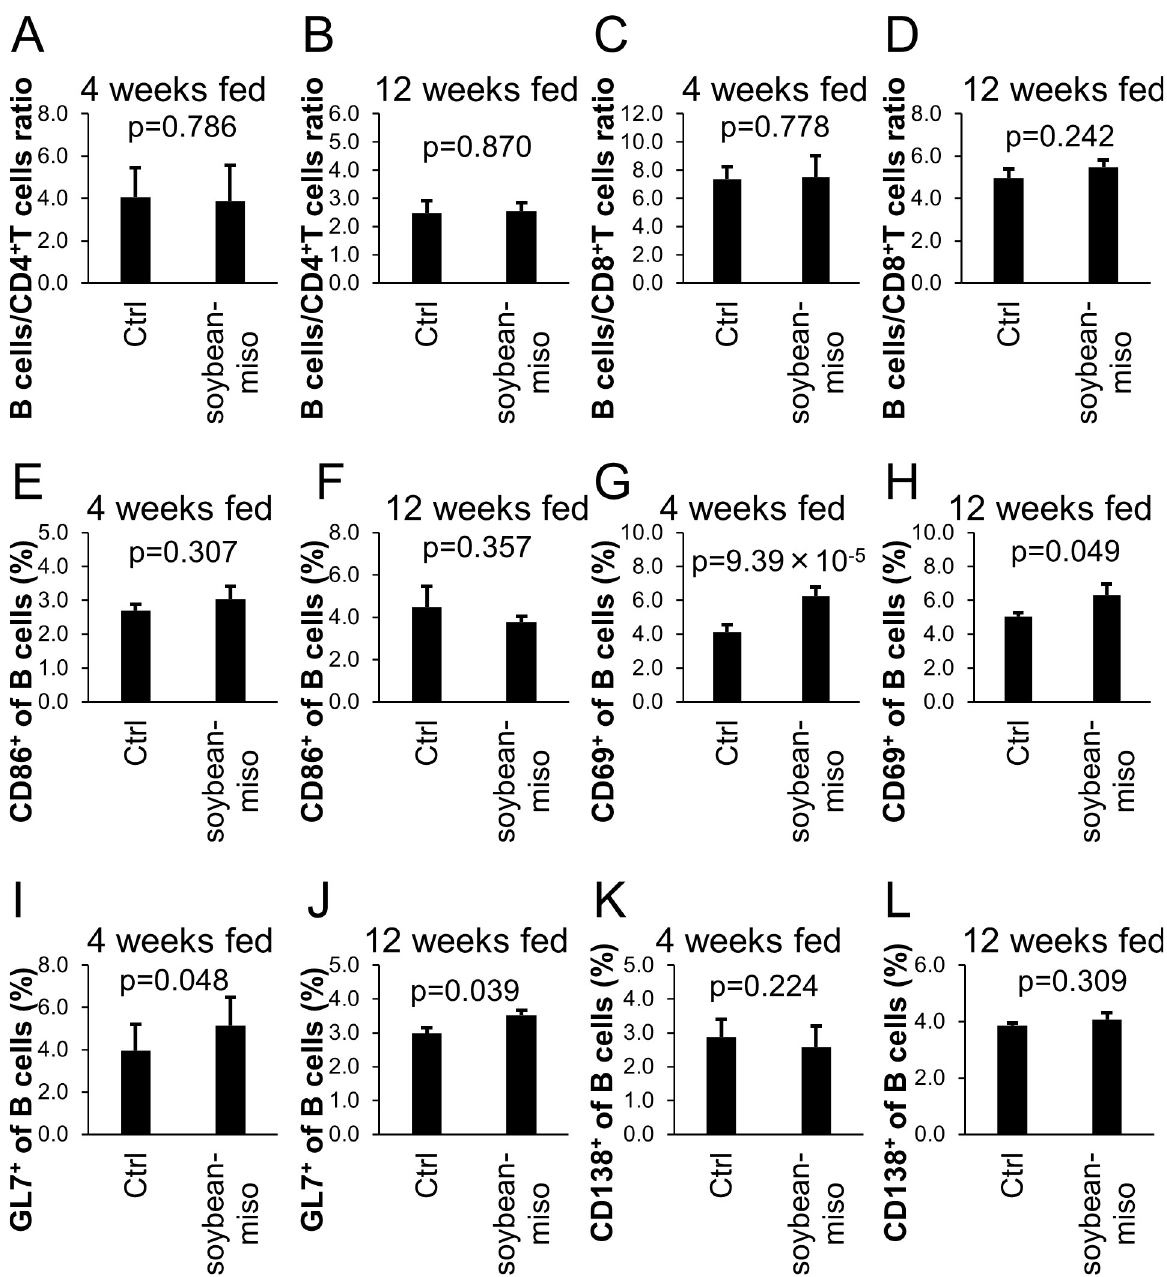
Fig 1. The effect of miso on B cells and T cells in mouse spleens. (A) The ratio of B220 + /CD4 + cells fed for 4 weeks. (B) The ratio of B220 + / CD4 + cellsfed for 12 weeks. (C) The ratio of B220 + /CD8a + cells fed for 4 weeks. (D) The ratio of B220 + /CD8a + cells fed for 12 weeks. (E) The rate of CD86 + /B cells fed for 4 weeks. (F) The rate of CD86 + /B cells fed for 12 weeks. (G) The rate of CD69 + /B cells fed for 4 weeks. (H) The rate of CD69 + /B cells fed for 12 weeks. (I) The rate of GL7 + /B cells fed for 4 weeks. (J) The rate of GL7 + /B cells fed for 12 weeks. (K) The rate of CD138 + / B cells fed for 4 weeks. (L) The rate of CD138 + /B cells fed for 12 weeks. Diet containing 5% soybean-miso was fed to C57BL/6 mice for 4 (n = 12) or 12 (n = 3) weeks. Then, spleen samples were harvested and analyzed using flow cytometry. Bars indicate mean ± S.D. P-values relative to the control using a